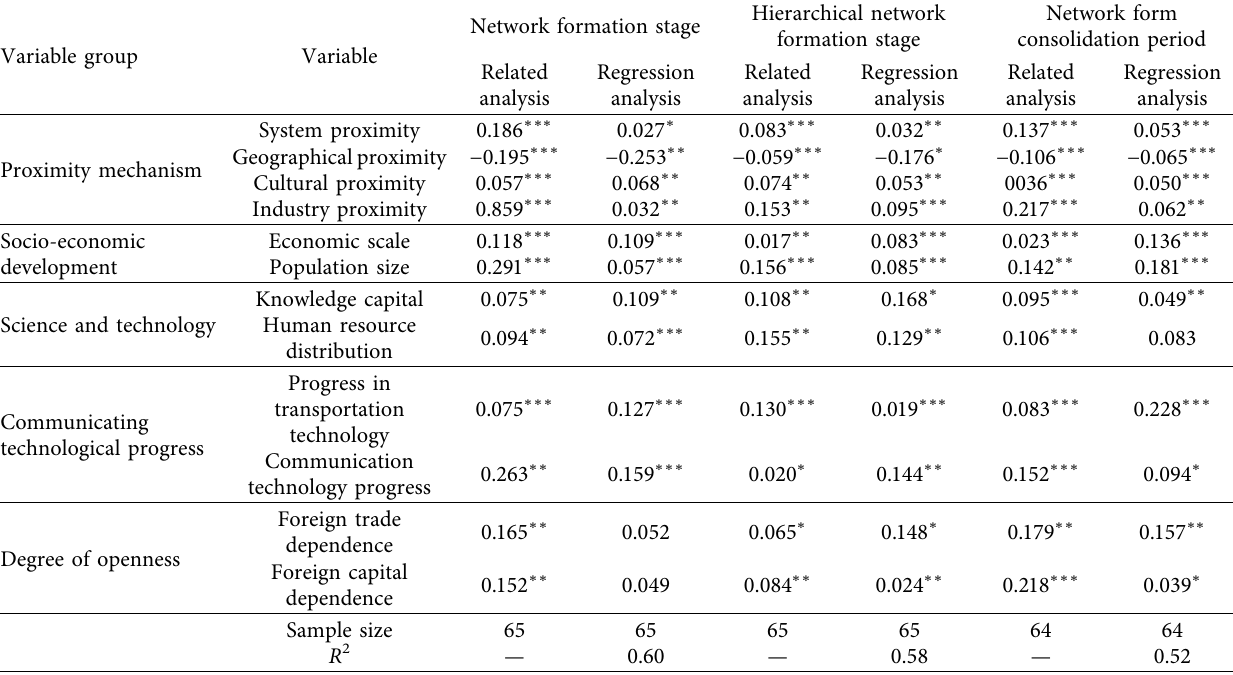
Table 2: QAP analysis results of the evolution of urban network structure in the Yellow River